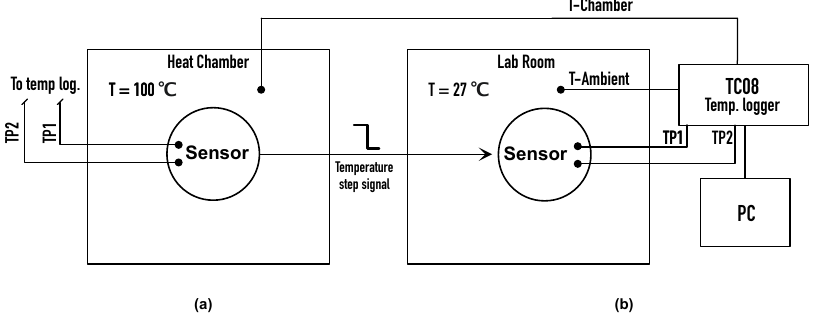
Figure 6. Measurement setup of a thermal step signal prototype response acquisition in thermal chamber ( a ) and in ambient temperature of laboratory room ( b ).